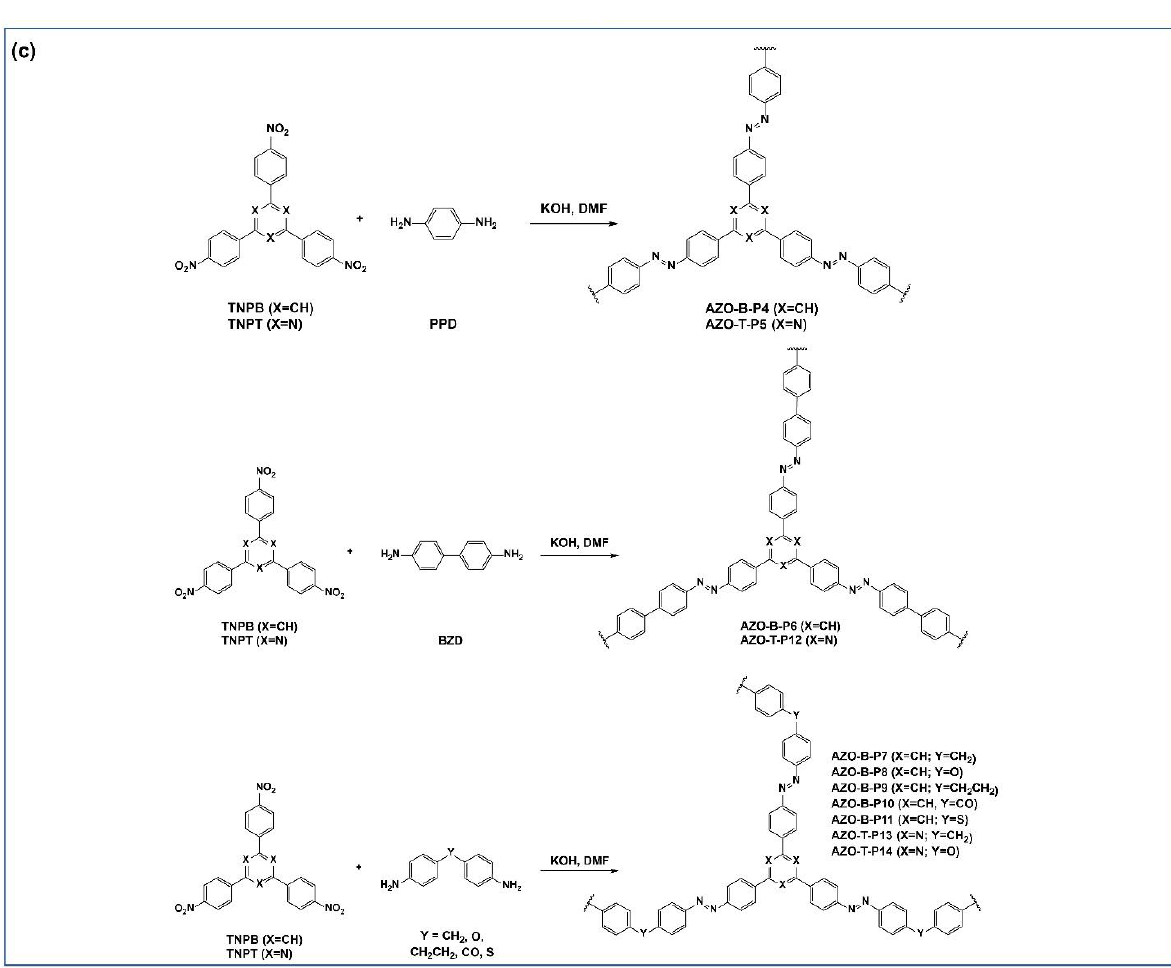
Figure 1. Synthesis of a series of benzene-(AZO-B-P) and triazine-based (AZO-T-P) azo-bridged polymers by ( a ) Zn- or NaBH 4 -mediated reductive homocoupling of aromatic nitro monomers (TNPB and TNPT); ( b ) copper(I)-catalyzed oxidative homocoupling of aromatic amino monomer (TAPT); ( c ) heterocoupling of aromatic nitro monomers (TNPB and TNPT) and various aromatic diamines under basic conditions.